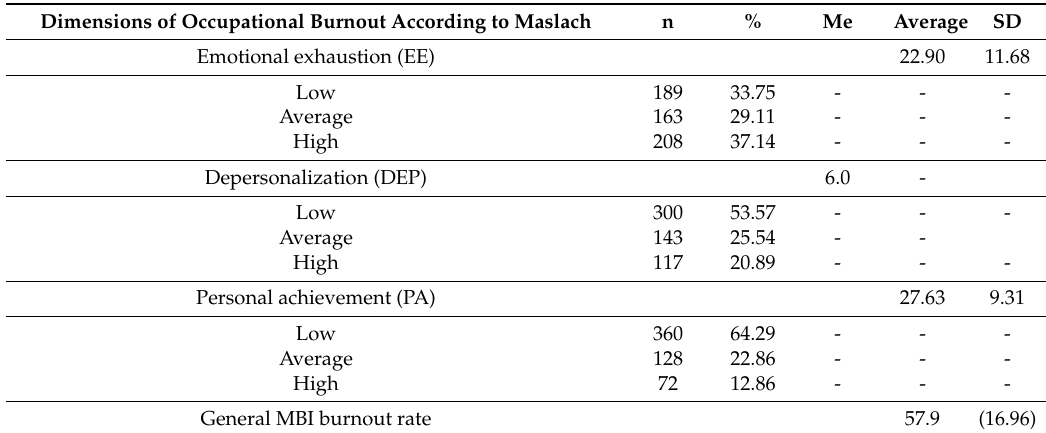
Table 2. The incidence of three dimensions of occupational burnout in the examined group of nurses. Dimensions of Occupational Burnout According to Maslach n